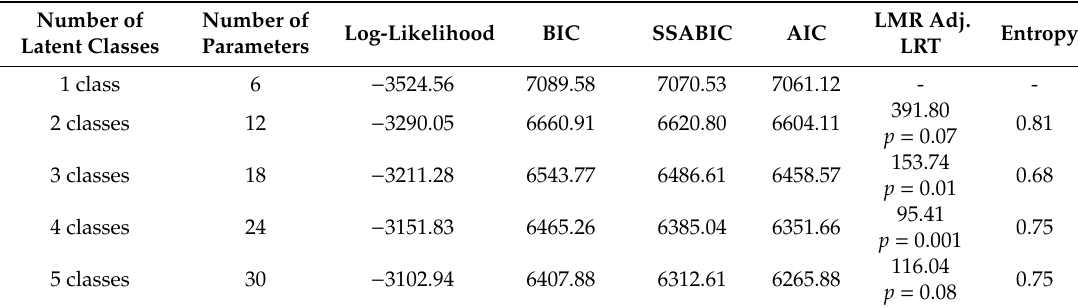
Table 3. Model indices for di ff erent latent class